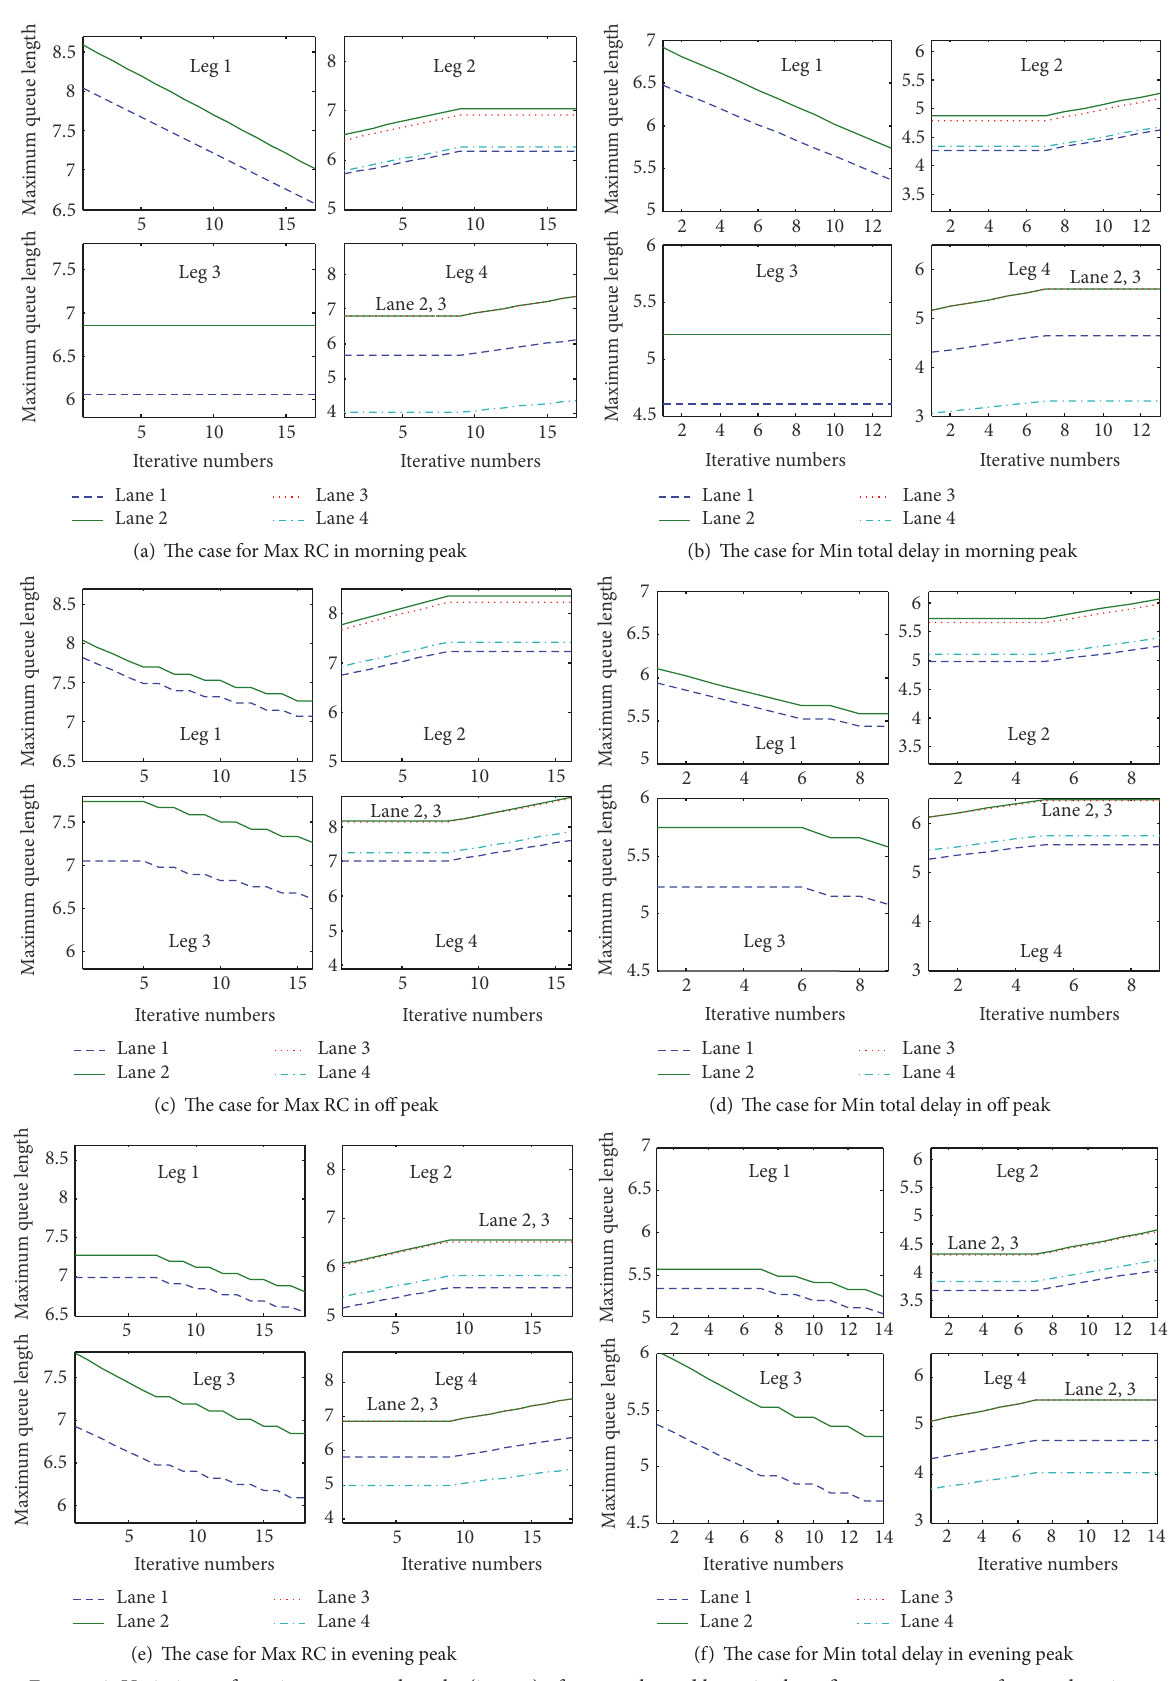
Figure 8: Variations of maximum queue lengths (in pcu) of approach road lanes in the refinement process of green